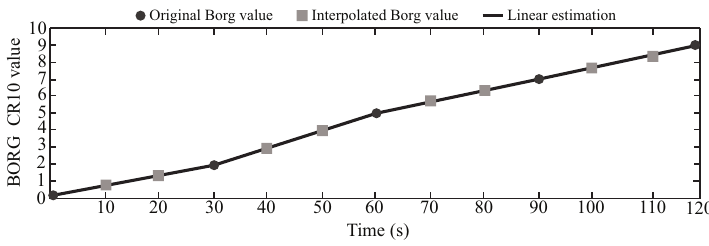
Figure 6. Linear interpolation of the Borg values every 10